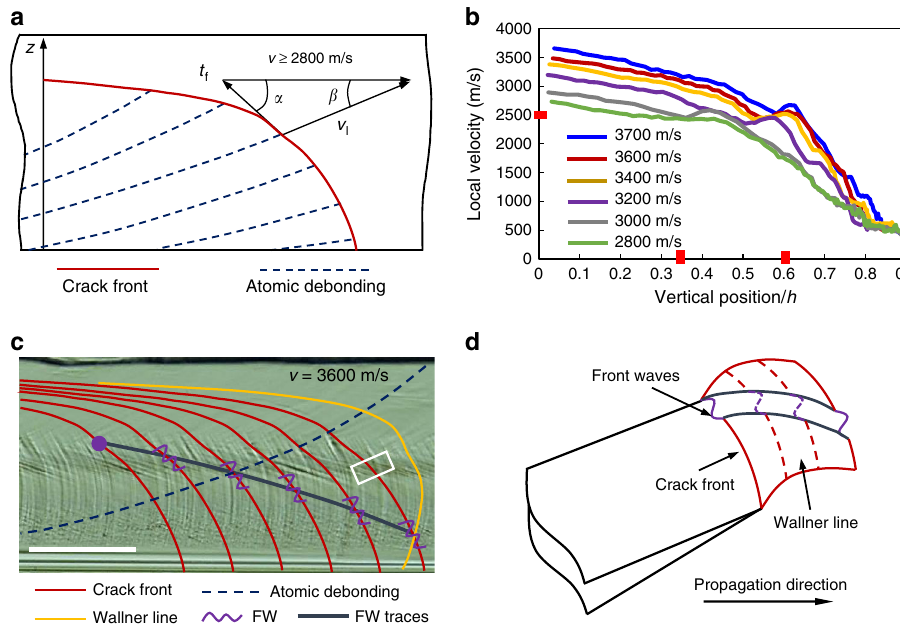
Fig. 6 Analysis of the front wave origin and generation process. a Relationship between the local velocity v l and the macroscopic propagation velocity v , t f is the local tangent of the crack front. b Local velocity pro fi les with respect to different propagation velocities. c Real scale schema on the FW generation and propagation, the trace is compared with the experimentally observed SSM. d Superposition of the FW traces on the surface undulation (Wallner lines) in the framed region in c . Scale bar: 100 μ